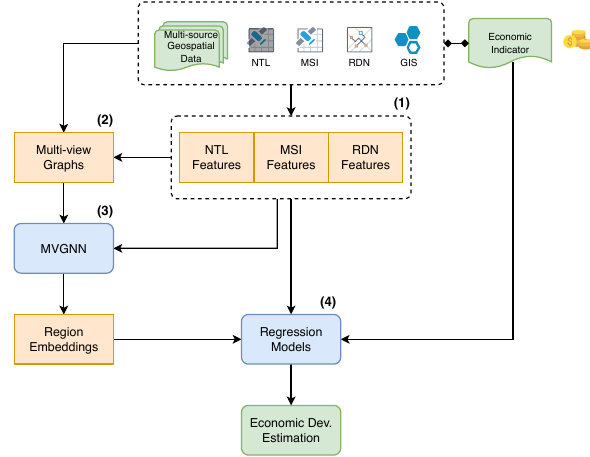
Figure 2. Overview of the workflow for economic development estimation from multi-source open geospatial data: (1) intra-region feature extraction, (2) inter-region correlation modeling via multi-view graphs, (3) region embeddings learning from MVGNN, (4) economic indicator